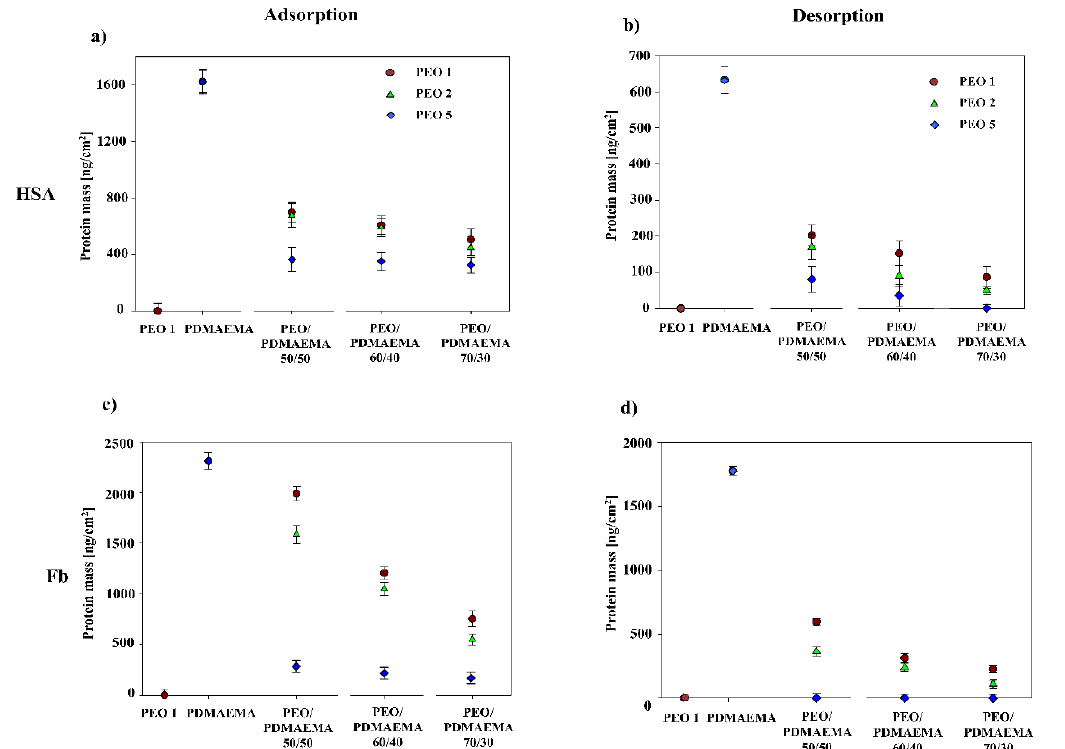
Figure 5. Protein mass obtained from the Sauerbrey modeling of ∆ f measured by QCM-D after adsorption (left, a , c ) and desorption (right, b , d ) on PEO1, PDMAEMA coatings, and the mixed PEO / PDMAEMA 50 / 50, PEO / PDMAEMA 60 / 40, PEO / PDMAEMA 70 / 30; dark red circles–coatings containing PEO1, green triangles –coatings containing PEO2, blue diamonds- coatings containing PEO5. Top: HSA mass after adsorption at I = 10 − 3 M, pH 7.4 and residual mass after desorption (ng / cm 2 ) at I = 0.15 M, pH 9.0) of HSA, bottom: Fb mass after adsorption at I = 10 − 3 M pH 7.4, and residual mass (%) after desorption at I = 0.15 M, pH 9.0.